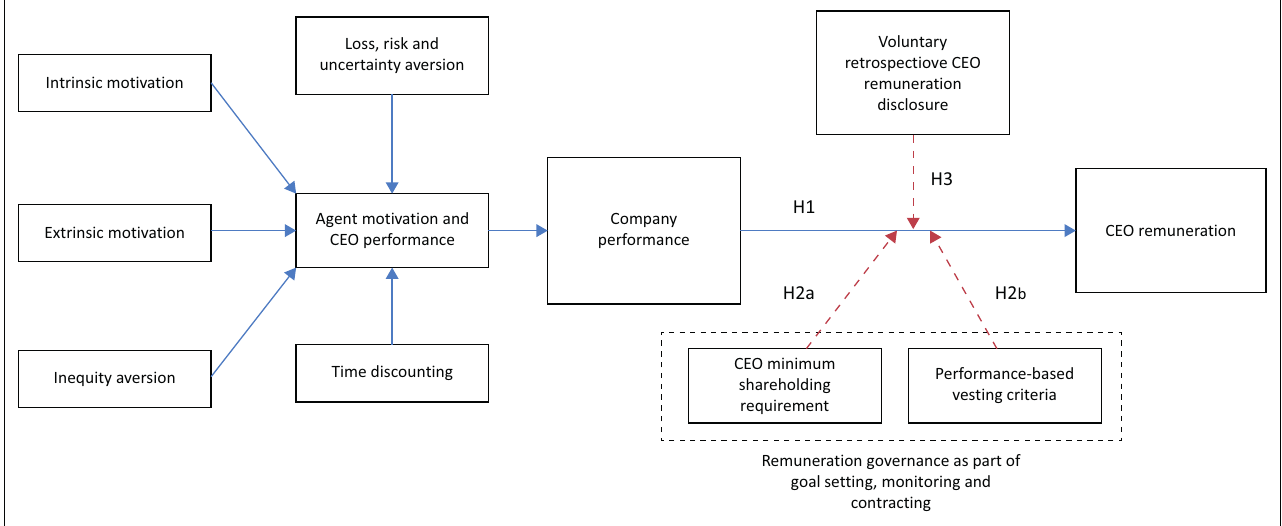
FIGURE 1: Conceptual